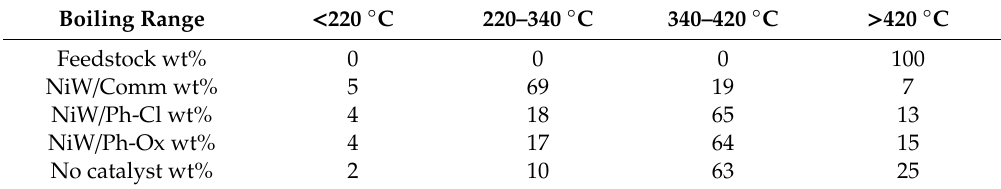
Table 5. Simulated distillation (SimDis) results of the DO tests and